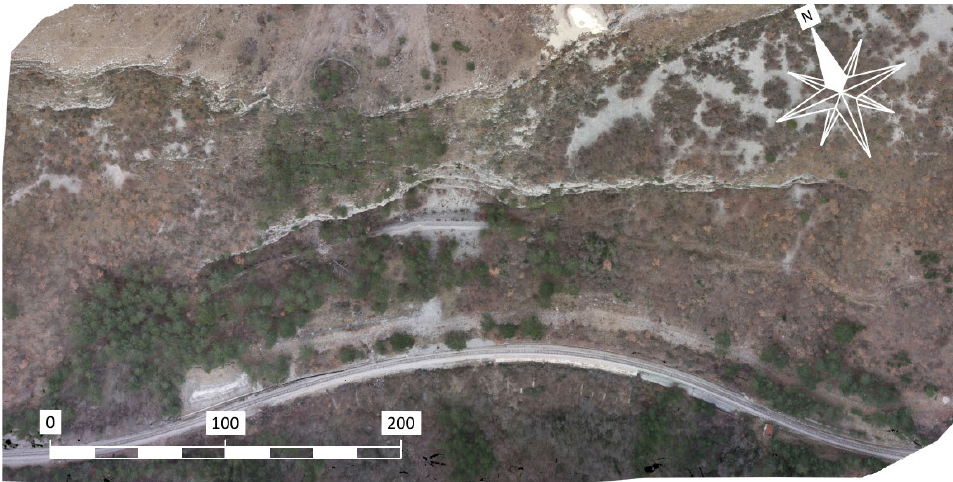
Figure 6. Orthophoto of Raspadalica Cliff derived from the SfM photogrammetry.